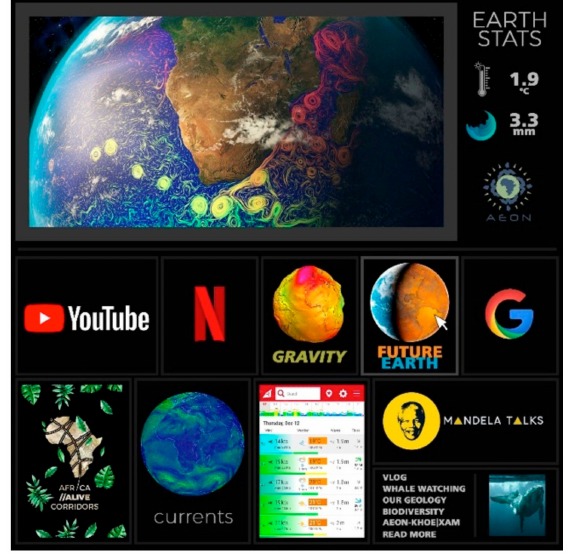
Figure 15. Prototype interface to communicate and share ‘alive’ earth and cultural data in southernmost Africa (see also ‘Mandela Talks’